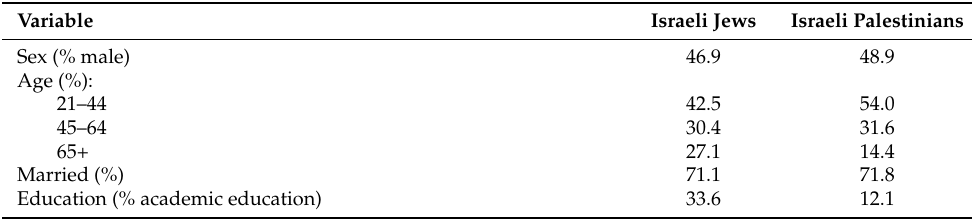
Table 1. Descriptive statistics for the